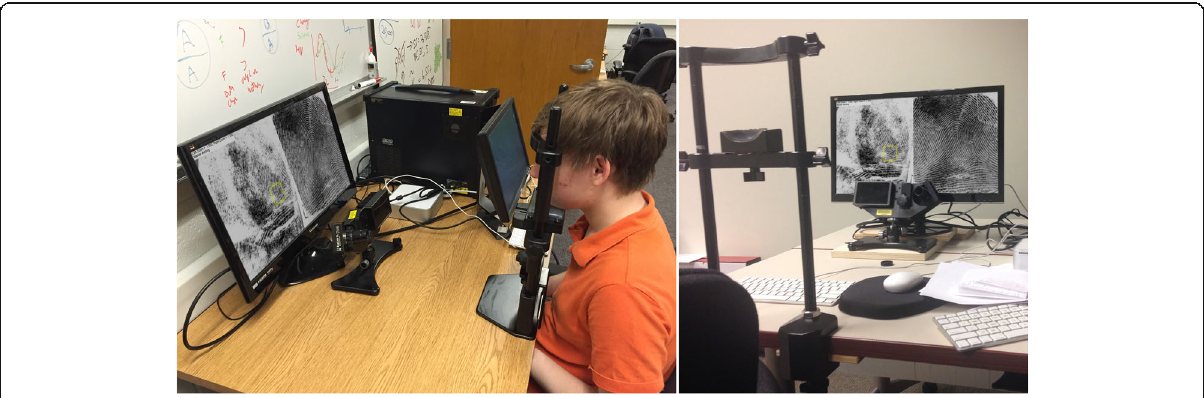
Fig. 2 Examples of testing setup. The left image illustrates the main monitor with the eye-tracker below it. The experimenter ’ s monitor, presentation computer, and eye-tracker computer are to the right of the subject. (Images from actual trials on monitors added for